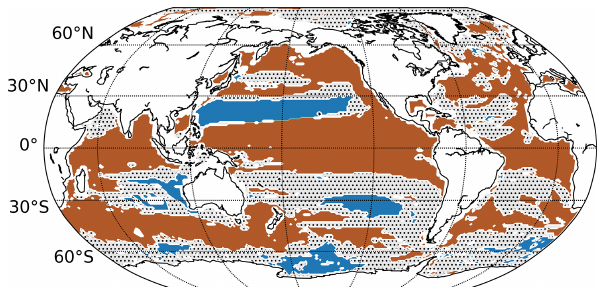
Figure 7. Summary map showing the regions where oxygen changes emerge before temperature changes (blue areas; (cid:49) ToE > 0 with (cid:49) ToE = ToE( T ) − ToE(O 2 )) and where temperature changes emerge before oxygen changes (brown areas; (cid:49) ToE < 0) for at least seven out of nine models. The dashed areas show the regions where more than three models differ in the sign of (cid:49)